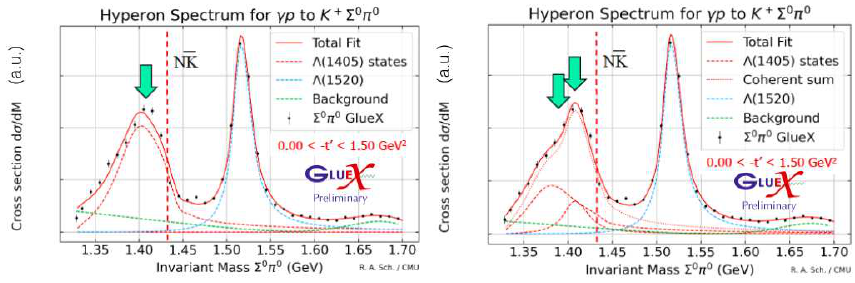
Figure 3: Comparison of two hypotheses for the Λ (1405) line shape, di ff ering by having either one or two coherent Flatté amplitudes in the fi ts. Green arrows indicate the